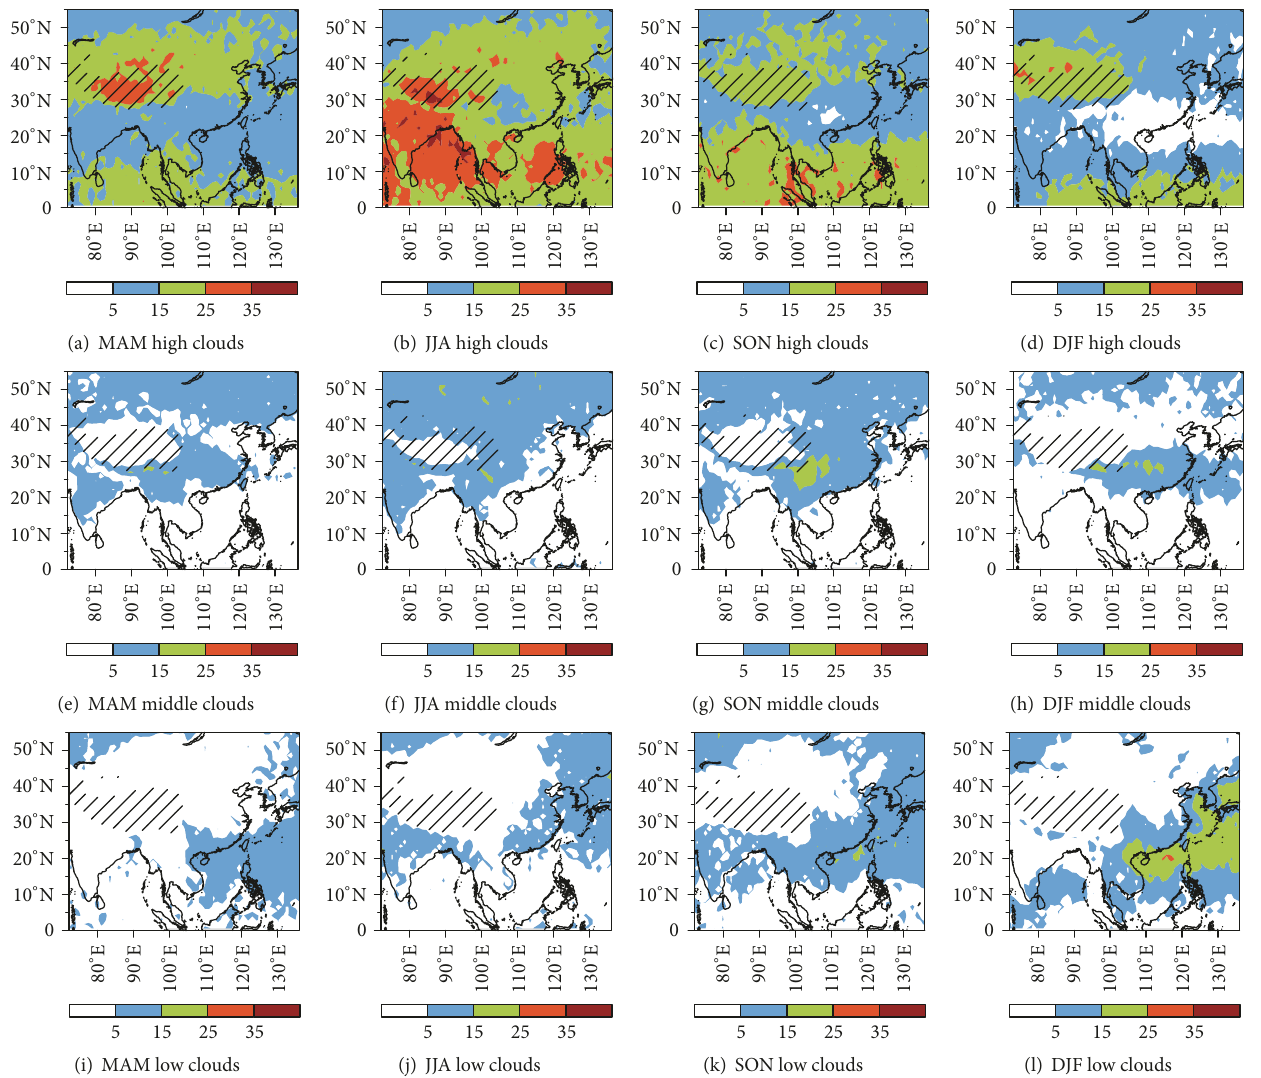
Figure 9: Distribution of single-layer cloud occurrence at different heights (high, middle, low) over China and surrounding areas in different seasons (MAM, JJA, SON, and DJF), %. The shaded part indicates that the surface elevation is above 3.1 km (680